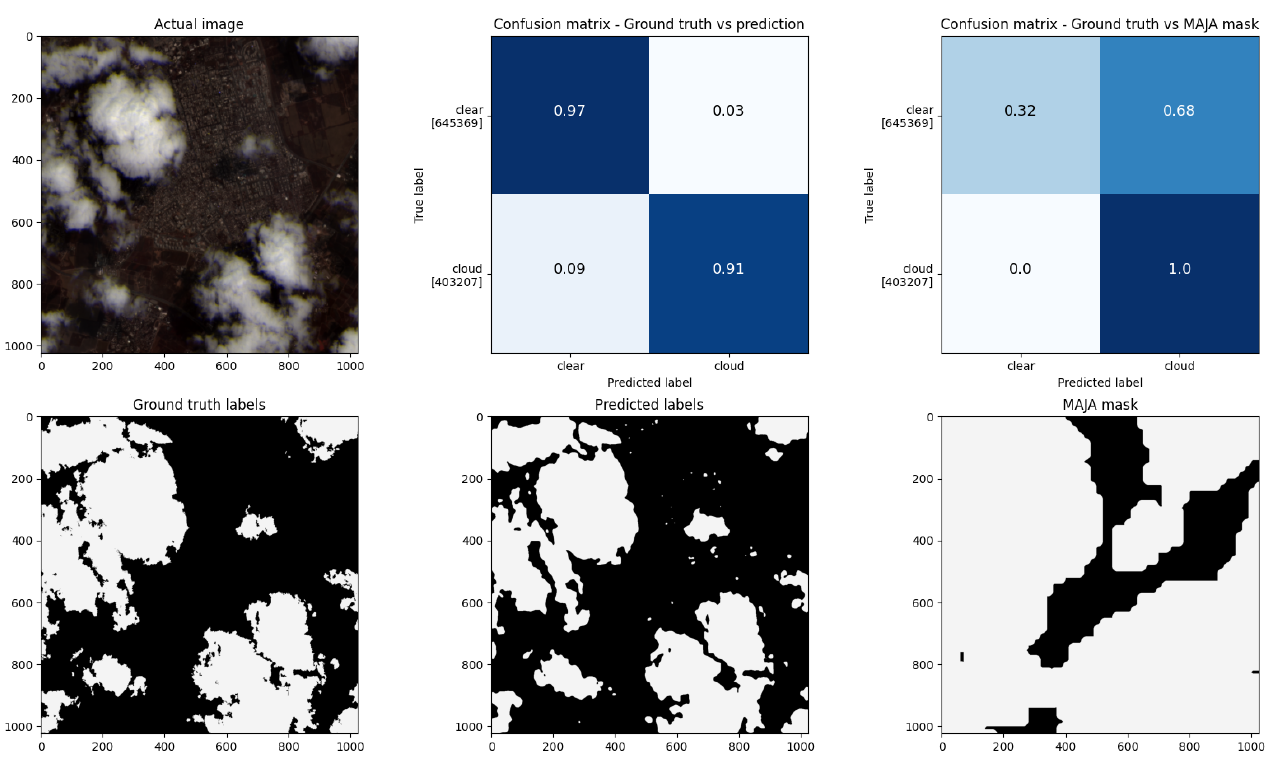
Figure 15. Comparison of the MAJA cloud mask and results from the binary detection of U-Net without dropout layers trained on the full-band dataset. A patch of S01 tile covering an urban area.